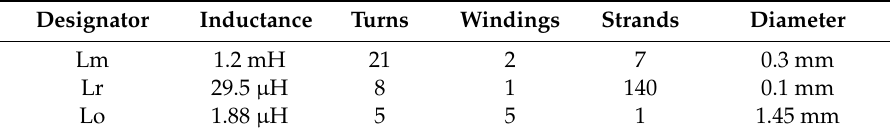
Table 7. Inductance values and their winding realization in optimized design.